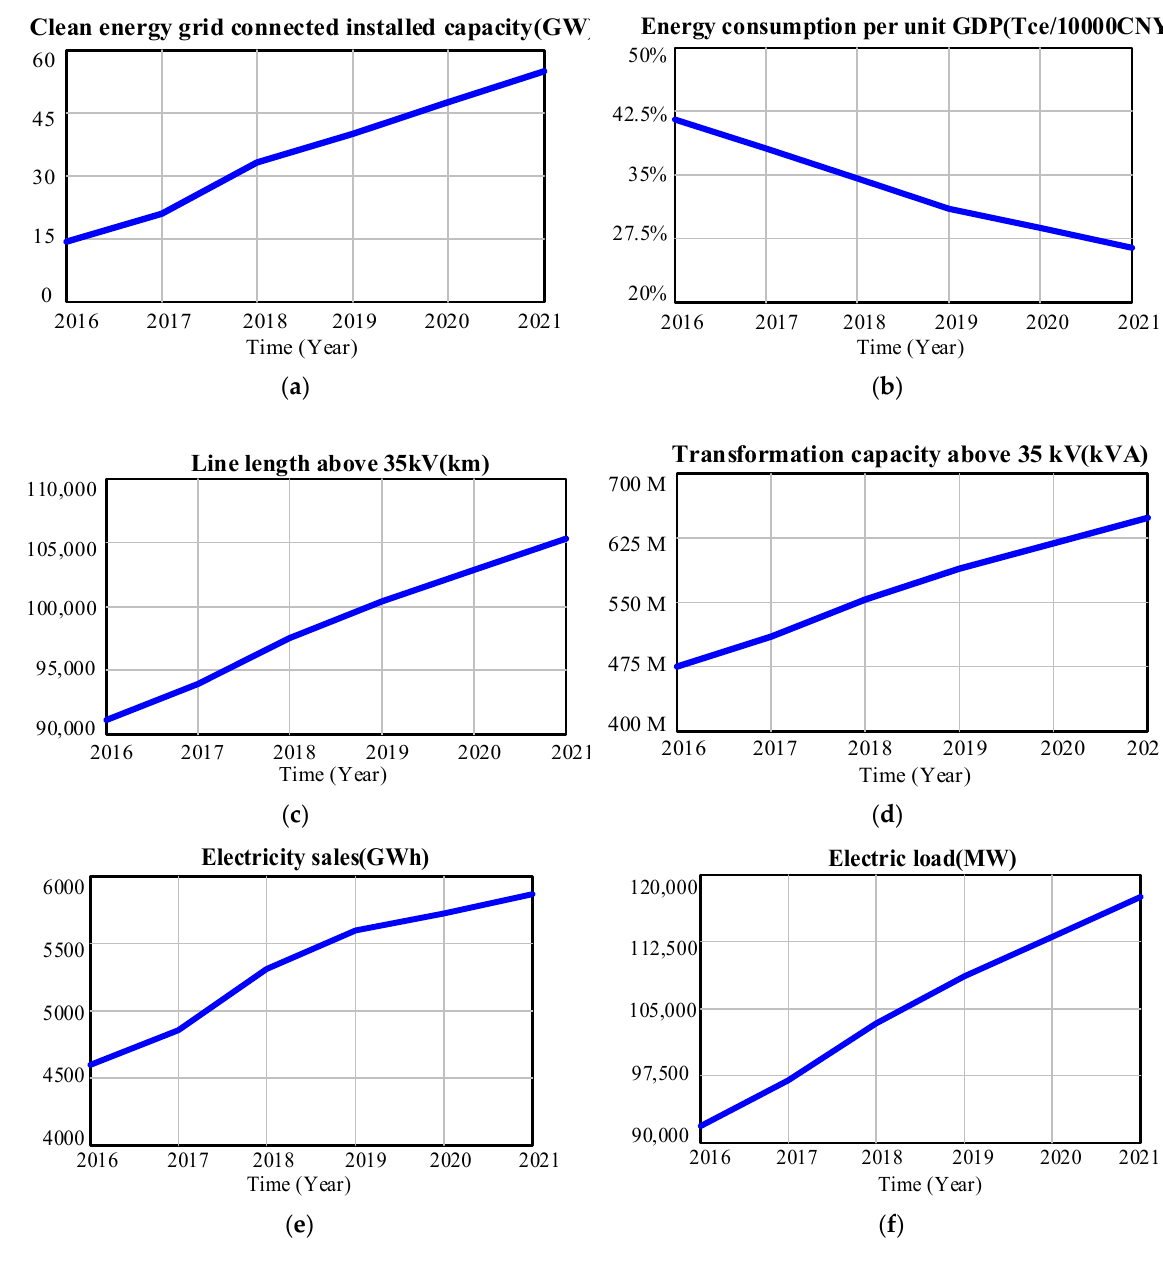
Figure 7. Simulation value of ESG investment state variable of grid company from 2016 to 2021, including ( a ) Clean energy grid-connected installed capacity; ( b ) Energy consumption per unit GDP(Tce/10000CNY); ( c ) Line length above 35 kV; ( d ) Transformation capacity above 35 kV; ( e ) Electricity sales; ( f ) Electric load.